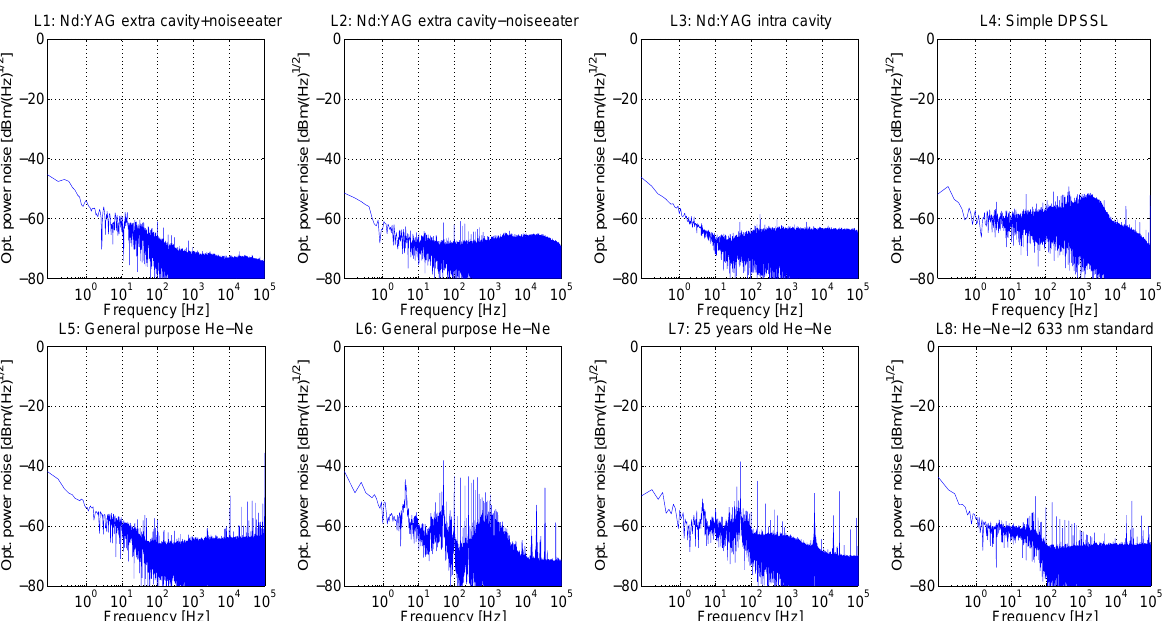
Figure 4. Optical power (amplitude) noise measurements of tested laser